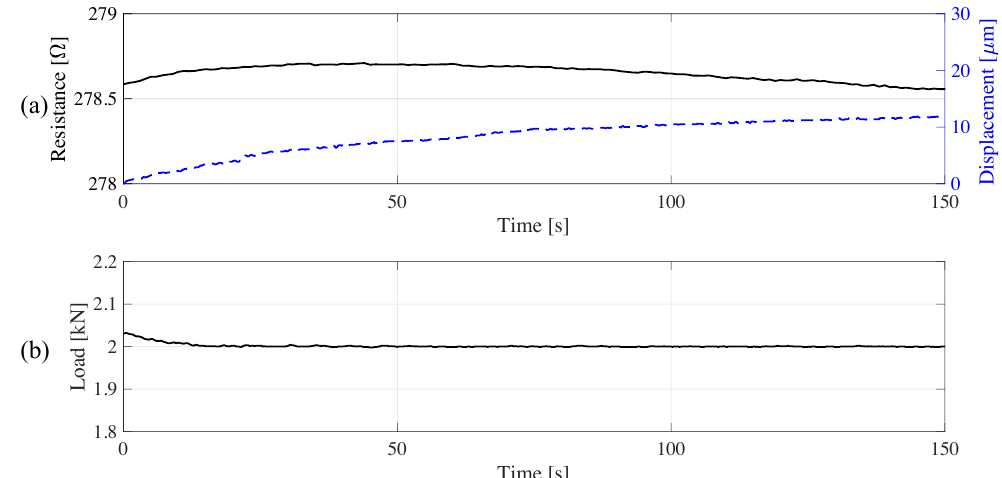
Figure 11. Plate response to the loaded polarization test: ( a ) resistance and displacement of the top of the plate; ( b ) load time history.